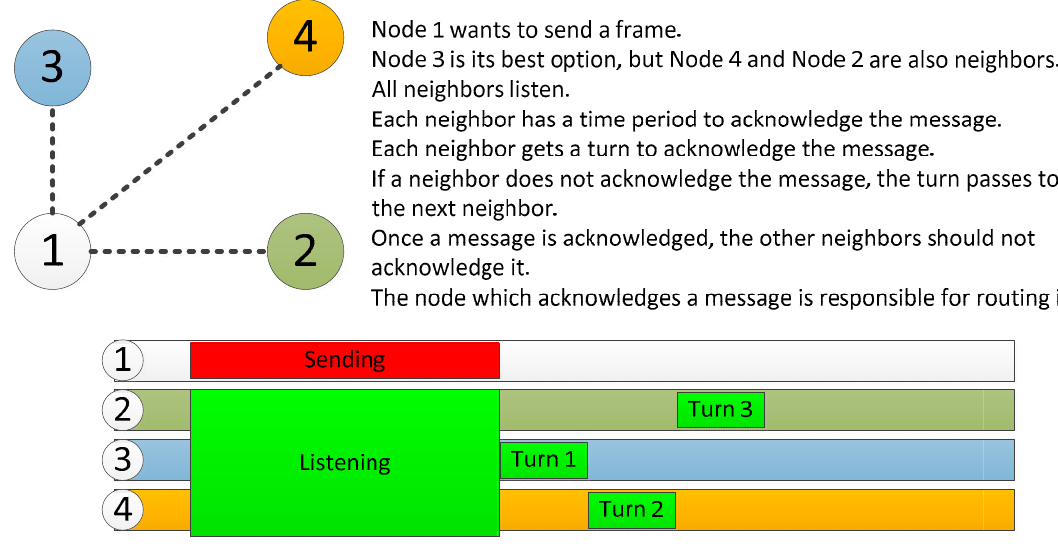
Figure 4. Simplified routing mechanism.